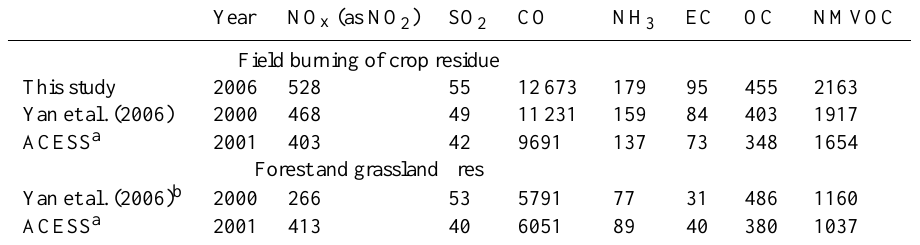
Table 2. Emissions from open biomass burning in China (Gg species yr − 1